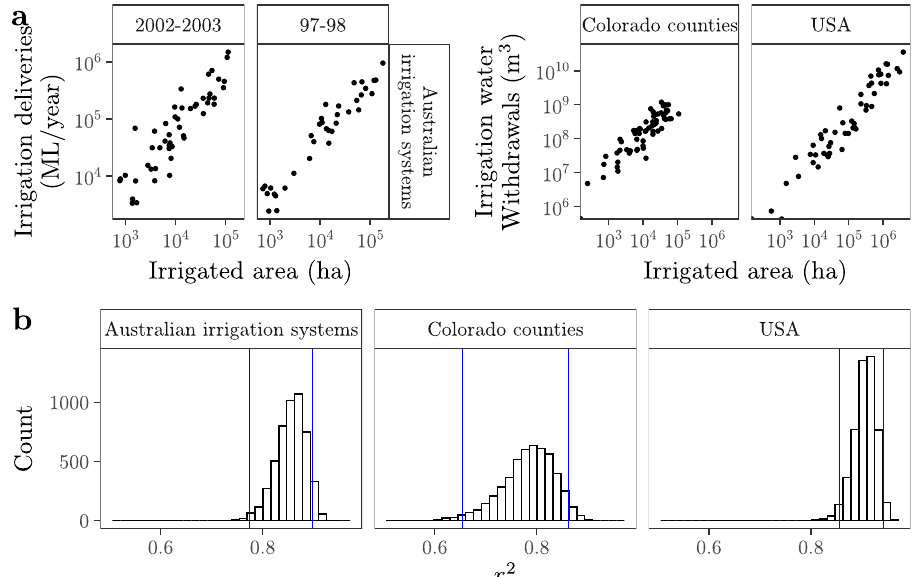
Fig. 6 Examples of the relation between irrigated areas and irrigation water withdrawals at smaller geographical scales. a Scatterplots presenting data for circa 60 Australian irrigation systems 41,42 , Colorado counties 44 and North-American States 45 . b Distribution of r 2 after bootstrapping ( R = 5000). The blue lines show the 95% con fi dence intervals, calculated with the bias-corrected and accelerated (bca) method 97 . See Figs. S21 and S22 for the regression